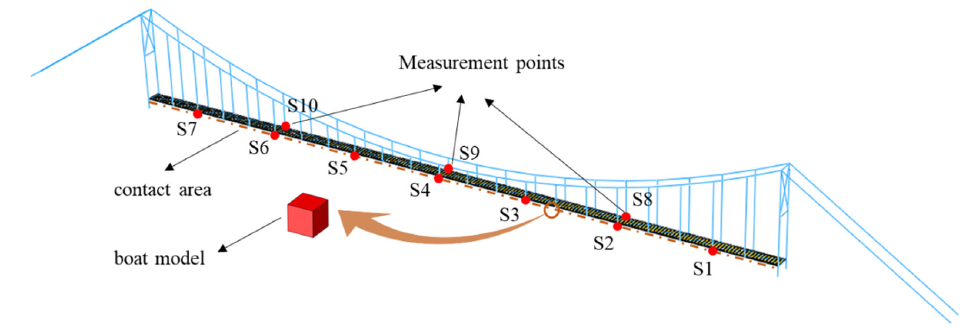
Figure 7. Bridge/ship impact analysis illustration.